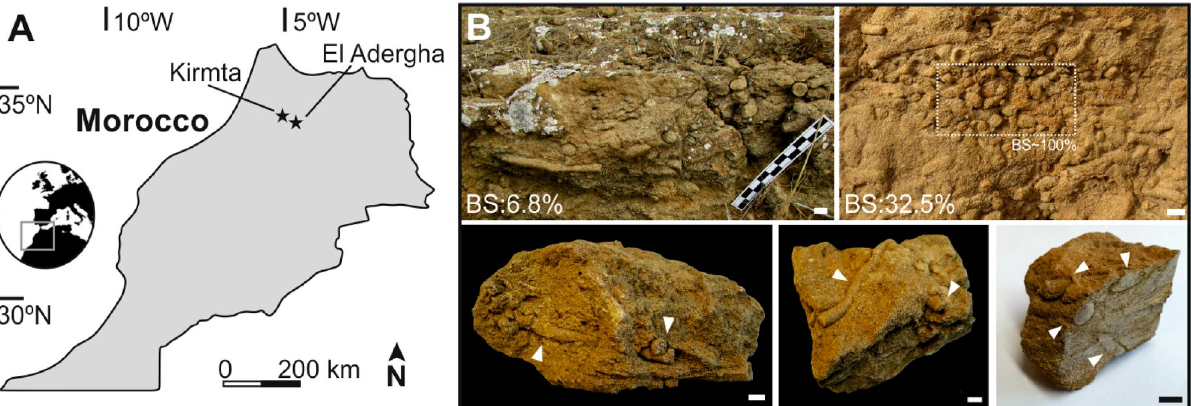
Figure 1. ( A ) Location map of the samples. ( B ) Outcrops and rock samples containing Macaronichnus with different bioturbation intensity and overlapping between them. White arrows point to Macaronichnus in rock samples. BS Bioturbated Surface. Scale bars 1 cm.